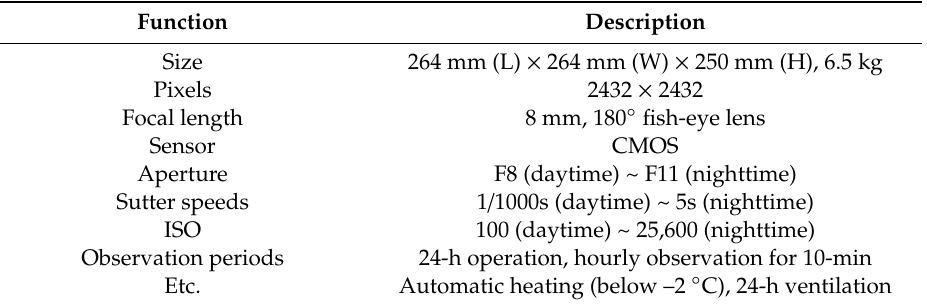
Figure 1. Exterior of Automatic Cloud Observation System (ACOS) ( a ) and its installation environment ( b ). Table 1. Detailed specifications of